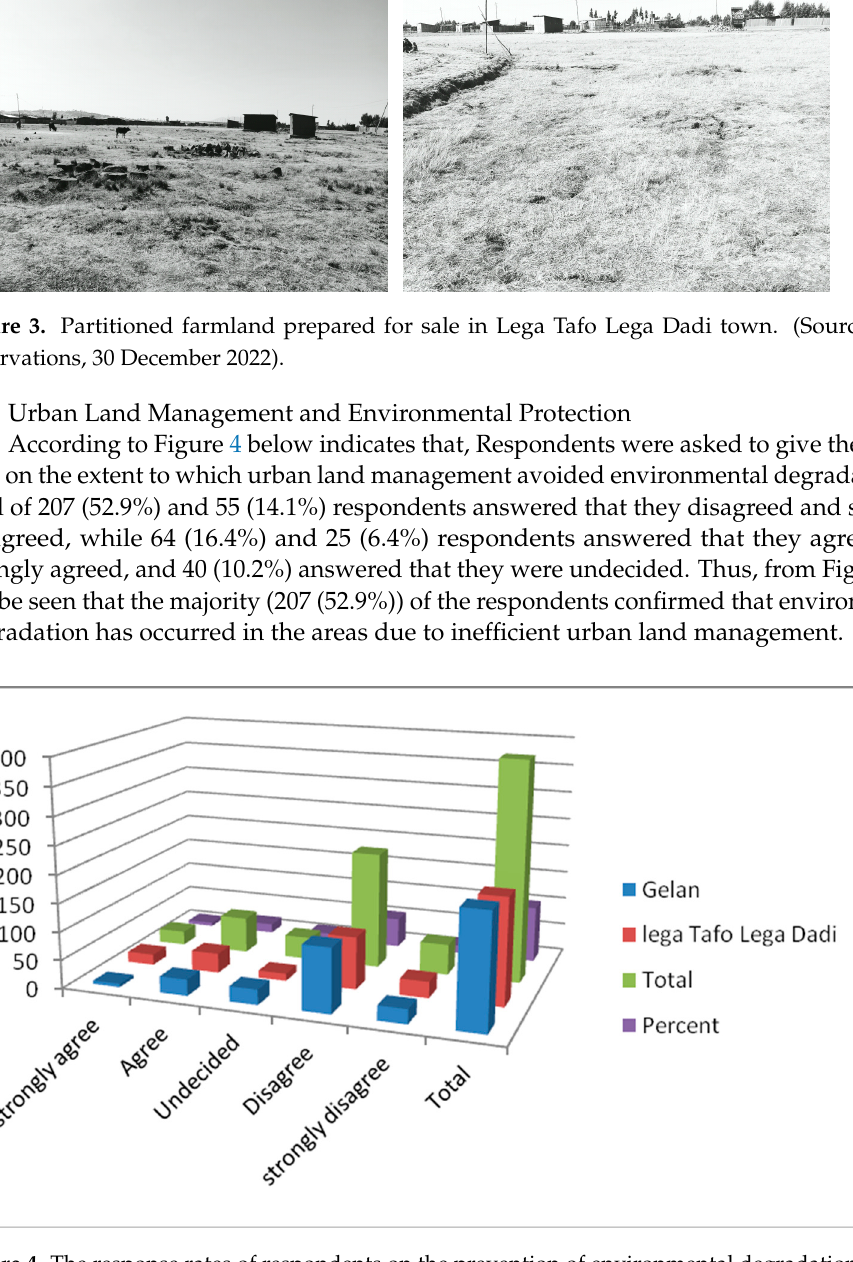
Figure 4. The response rates of respondents on the prevention of environmental degradation (source: survey results, 2022).